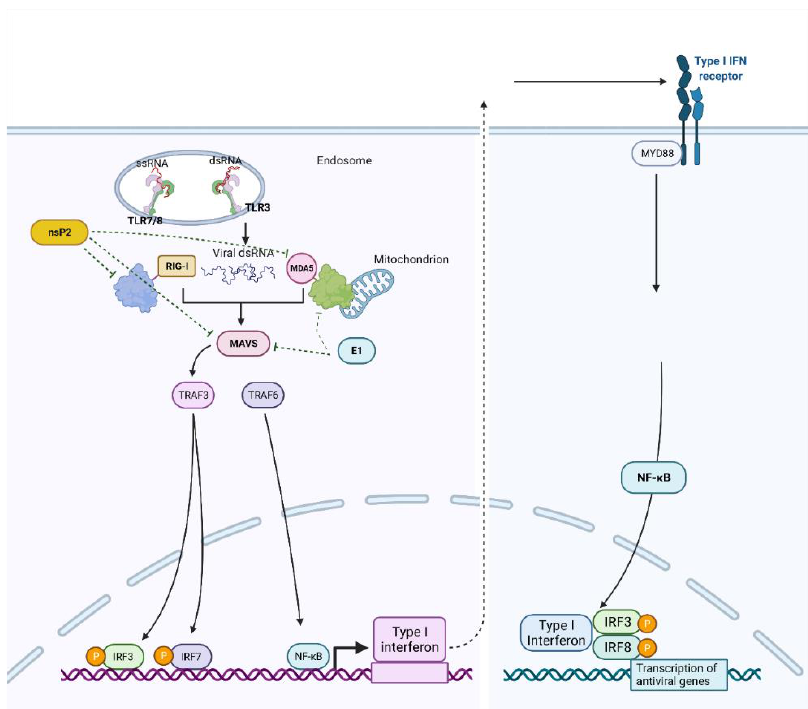
Figure 6. Proposed CHIKV signalling cascades. Engagement of the pathogen receptors in cells (TLR-X) and (RIG-I) induces a cascade that activates the type I interferons. Recognition of viral RNA in the endosomes of infected cells leads to the recruitment of adaptor proteins such as MyD88. This results in activating several signalling cascades and the phosphorylation of transcription factors: IRF3, IRF7 and NF-kB (Nuclear factor kappa B). When phosphorylated, these transcription factors can translocate from the cytosol into the nucleus and induce the transcription of type I interferons (IFN- α and IFN- β ) and proinflammatory cytokines (IL-1b, IL-6, TNF- α ). CHIK nsP2, E2 and E1 proteins suppress IFN- β through the MDA5-RIG-I pathway. Created with BioRender.com (Accessed on 11 September